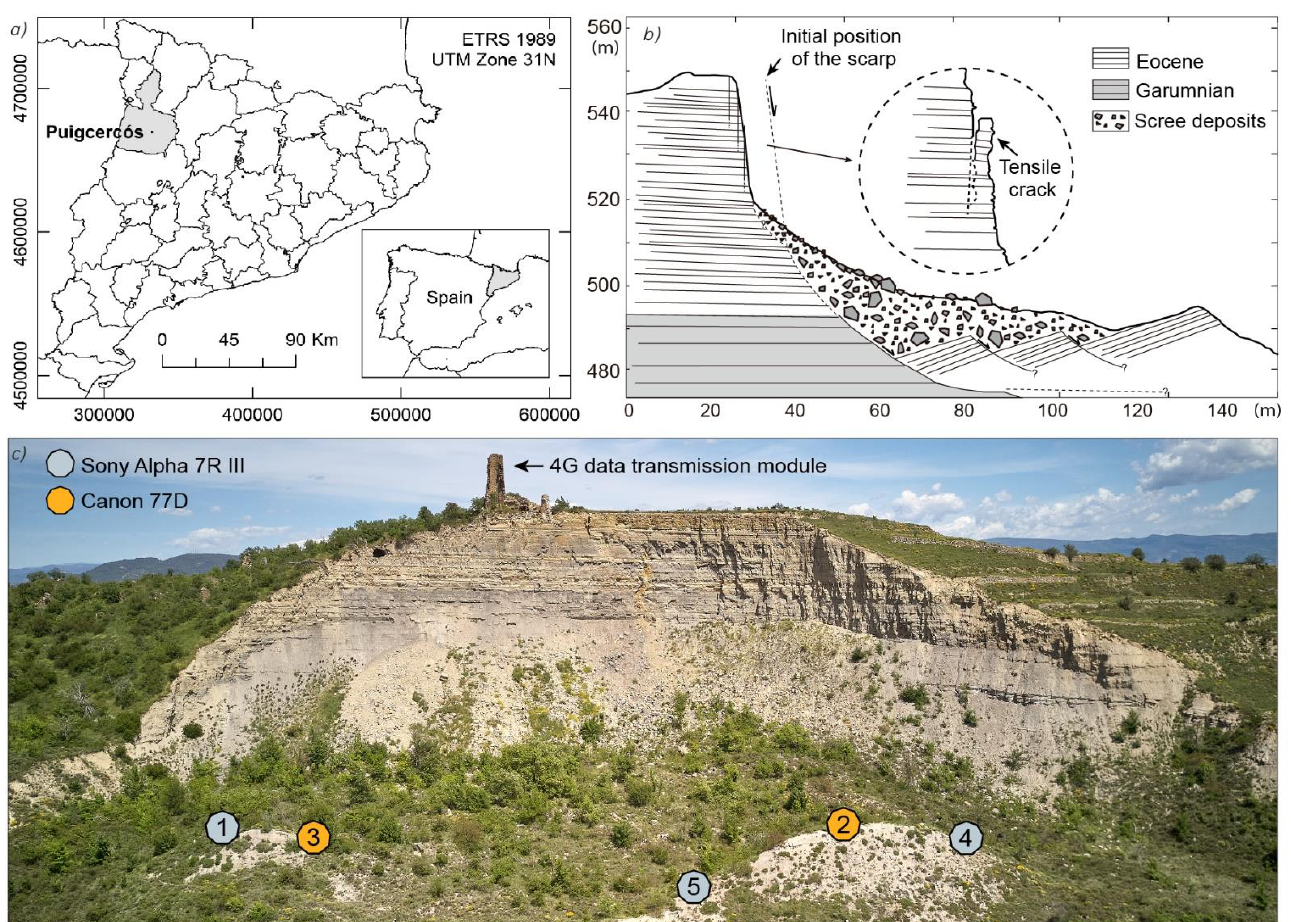
Figure 1. ( a ) Puigcercós location in Pallars Jussà region, Catalonia, NE Spain. ( b ) Geomorphological scheme of the Puigcercós cliff and main rockfall mechanism (modified from Royán et al. [49]). ( c ) Distribution of the camera modules in front of the Puigcercós cliff.